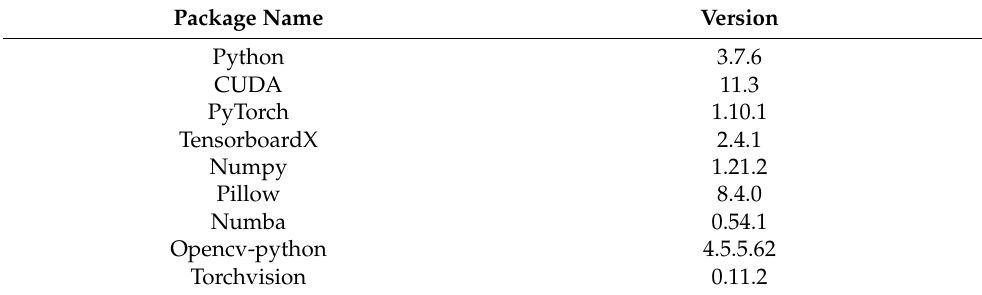
Table 2. Main installation packages required by the running